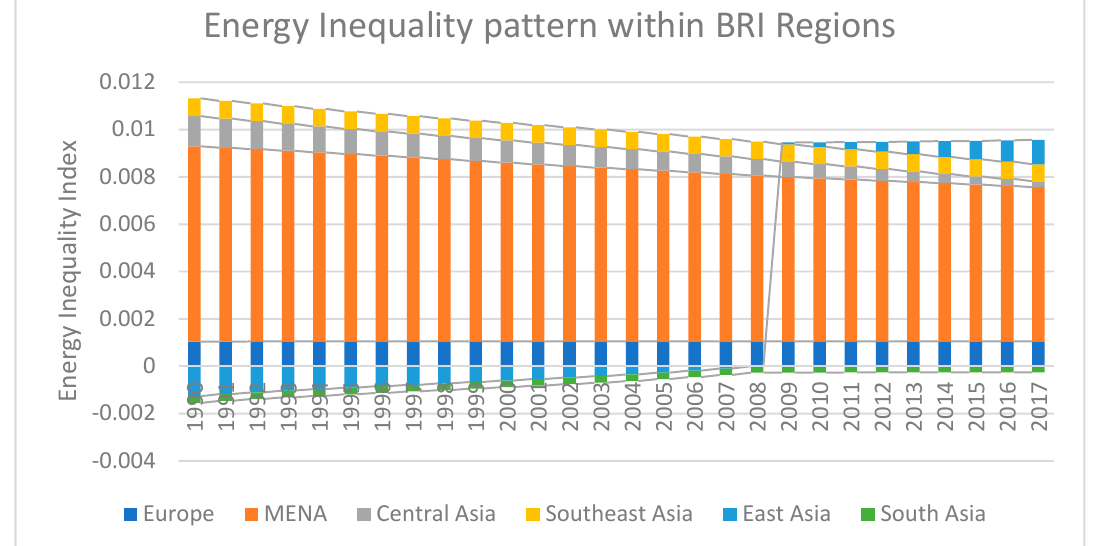
Figure 3. Energy Inequalities within BRI Regions.